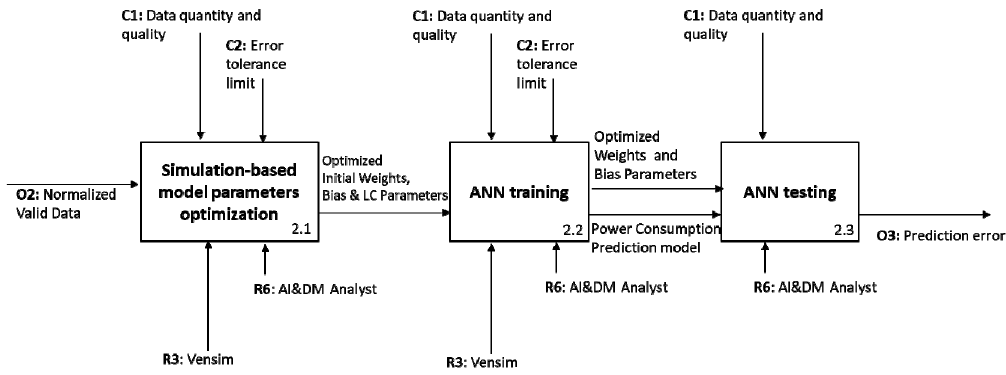
Figure 4. Level-2 representation of the Artificial Neural Network (ANN) model stage.